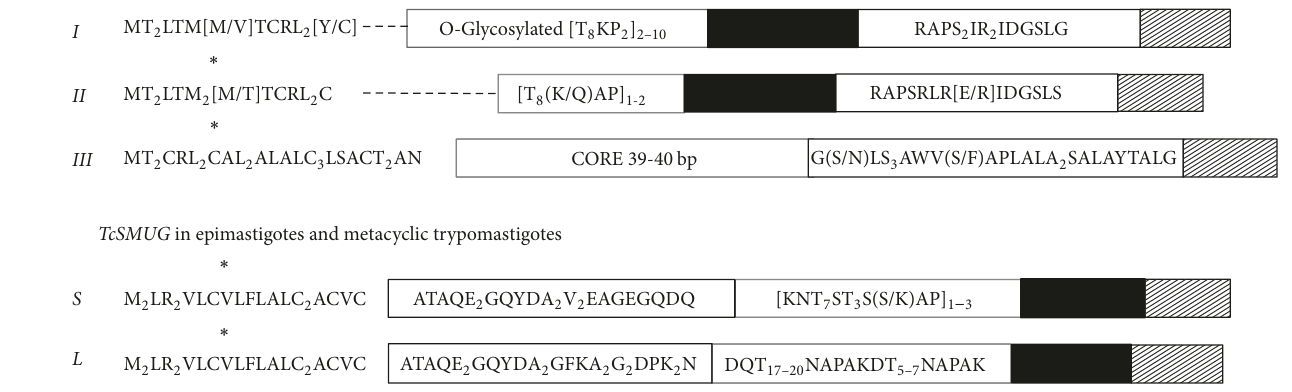
Figure 2: Mucin family. Schematic representation of mature proteins of mucin families TcMUC, found in bloodstream trypomastigotes, and TcSMUG, found in epimastigotes and metacyclic trypomastigotes. Signal peptide ( ∗ ); protein fingerprints (white boxes); hypervariable region (---); threonine-rich region (black boxes) and glycosylphosphatidylinositol- (GPI-) anchor signal (shadowed boxes). Image based on Buscaglia and Frasch [30, 60].